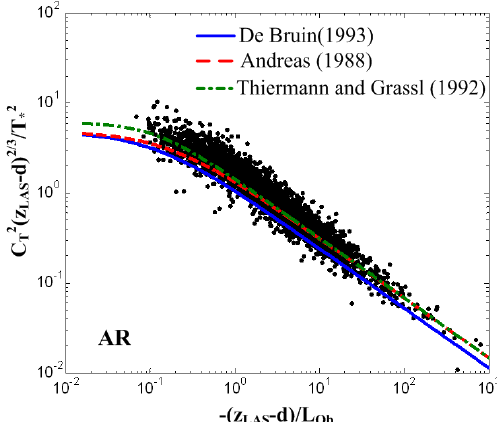
Fig. 6. Observed values of C T2 ( z LAS - d ) 2/3 / T *2 were plotted against ( z LAS - d )/ L ob under unstable conditions for the entire dataset(11 March to 31 October 2008, and 1 January to 30 June, 2009, 30-min, H LAS and H EC >50 W m -2 )